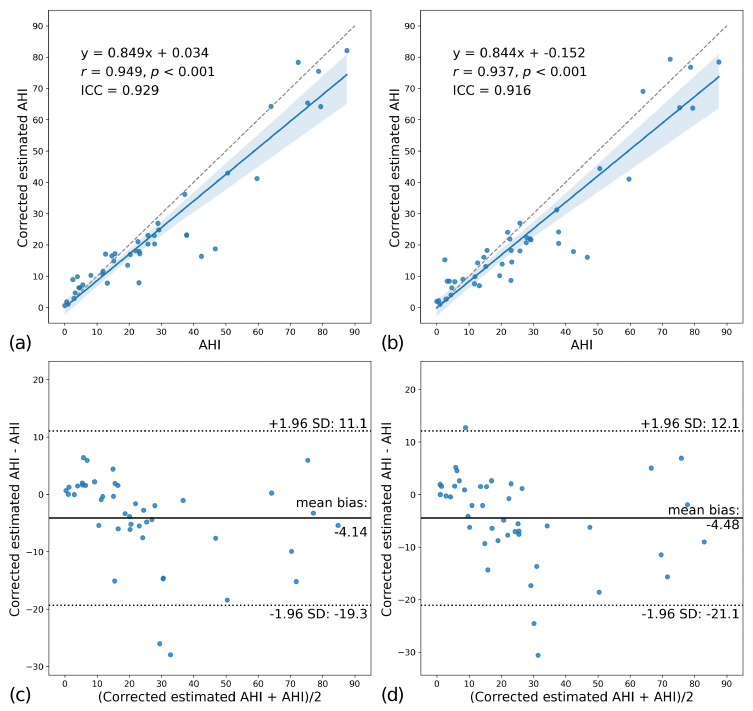
Figure 8. Comparison of the corrected estimated AHI with the ground truth for the binary ( a , c ) and multiclass models ( b , d ). ( a , b ) Scatter plots of corrected estimated AHI versus AHI showing the linear regression line (blue line) with 95% confidence intervals (blue shadowed area). ( c , d ) Bland–Altman plots of corrected estimated AHI and AHI.